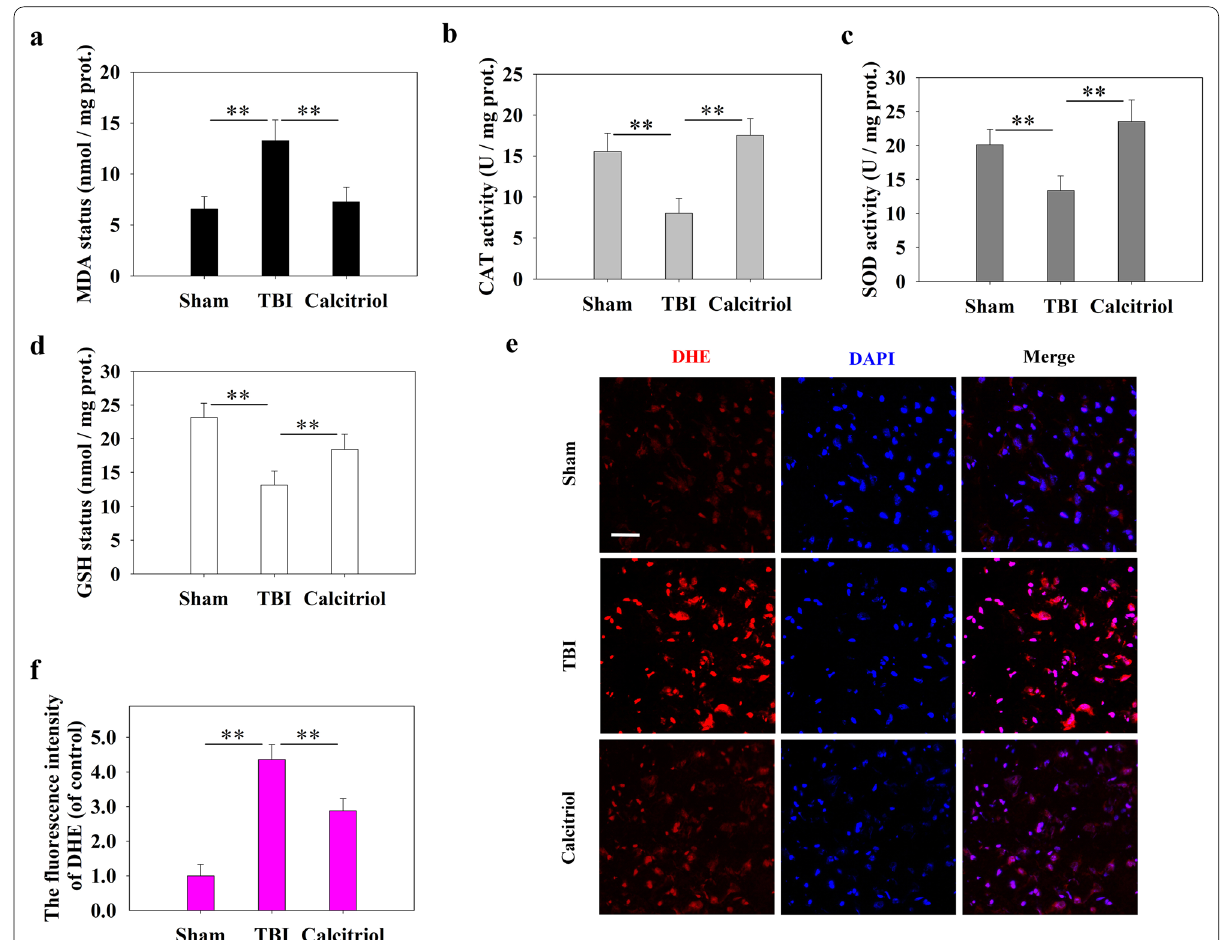
Fig. 5 Calcitriol (0.5 µg/kg) treatment ameliorated TBI-induced oxidative stress. a Malondialdehyde (MDA) status. b Catalase (CAT) activity. c Superoxide dismutase (SOD) activity. d Glutathione (GSH) status. e Representative images of immunofluorescence assays of dihydroethidium (DHE) (Bar 50 µm). f Statistical graphs of DHE-positive cells in different groups. Data are presented as means = groups. (Sham: sham-operated group; TBI: TBI model group; Calcitriol: TBI